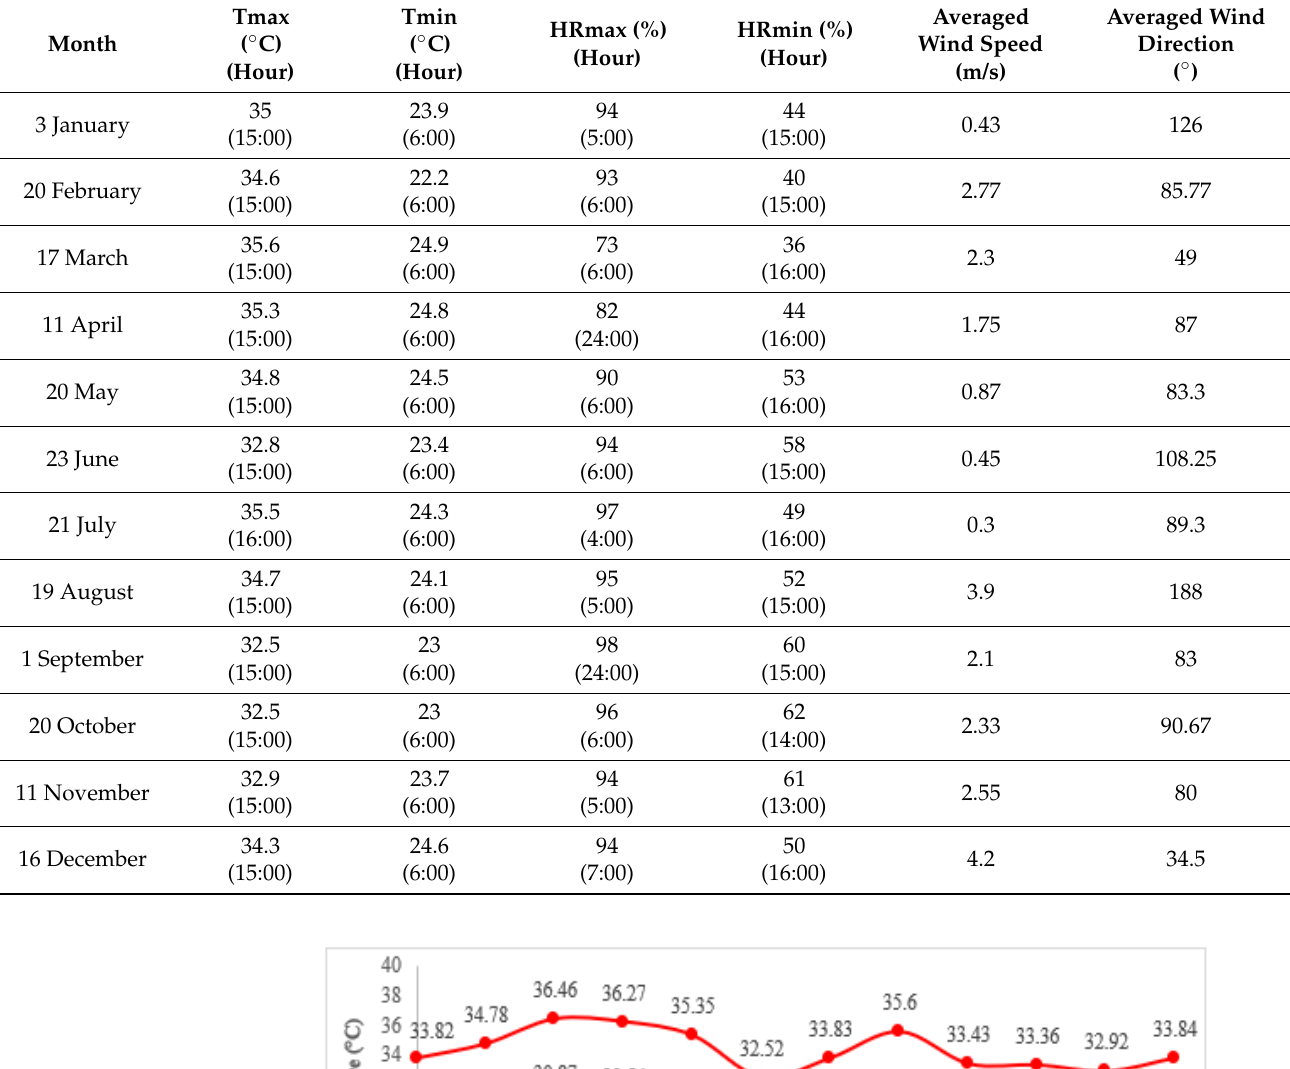
Table 5. Standard weather data used for simulation. Own elaboration.